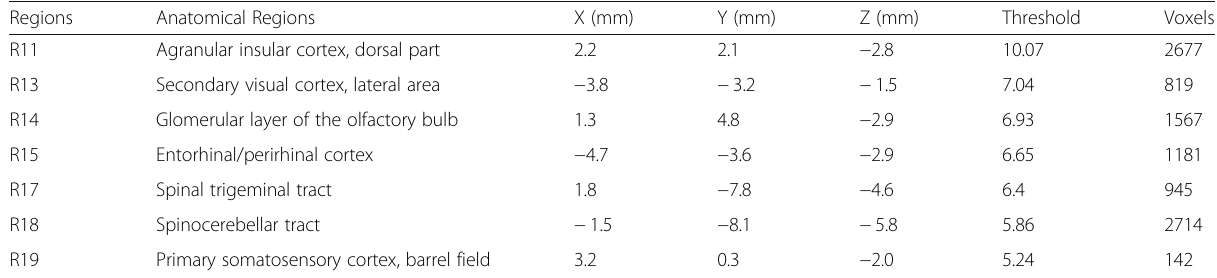
Table 2 Regional metabolic activity was decreased in WT mice after binge alcohol. Regions identified by SPM with decreases in metabolic activity in WT mice post-alcohol ( T = 4.3, P = 0.001) Regions